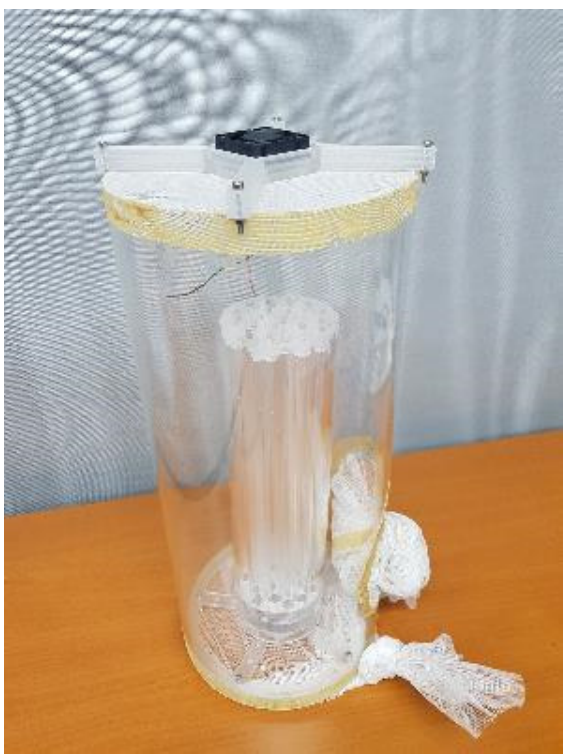
Figure 8. Flight ability test conducted on sterile male Anopheles arabiensis (Source: (Culbert et al. [314])) (Photo credit: H. Maiga).